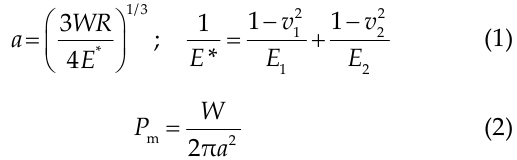
Table 1 The operating parameters for the dry sliding test.